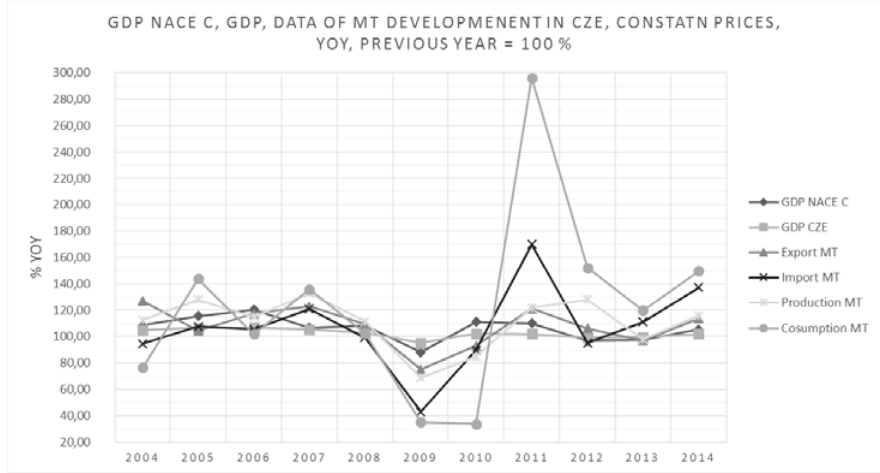
Fig. 3 - GDP in the Czech Republic, Czech industrial production, development of indicators in Machine Tools Branch in the Czech Republic from 2004 to 2014, constant prices. Source: CZSO 2016; EAT: Reports on the state of Machine Tools Branch in the Czech Republic